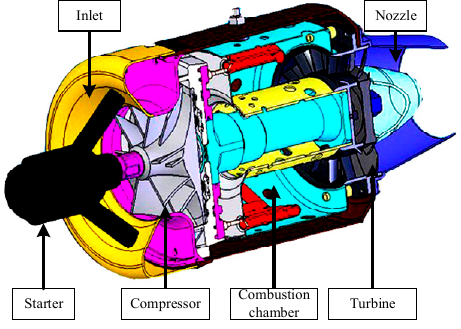
Figure 1. Turbojet engine structure.